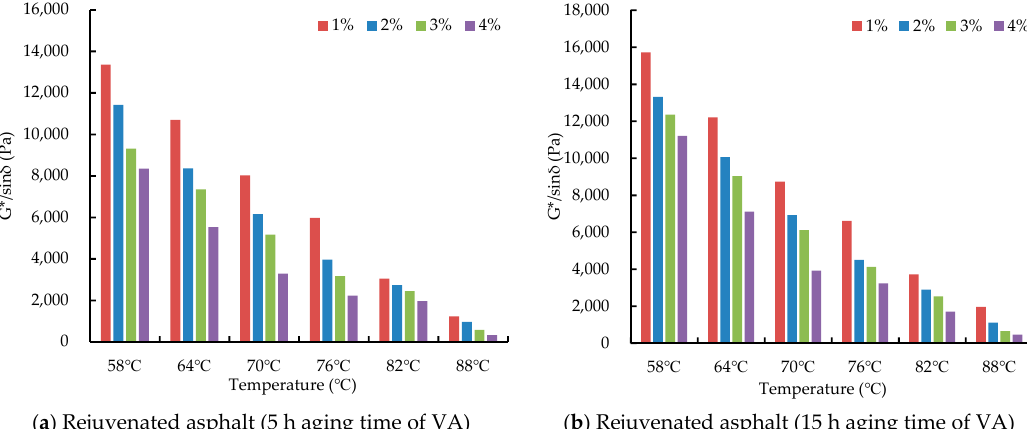
Figure 16. Influences of WCO on rutting resistance factor of rejuvenated asphalt (different aging time of VA).